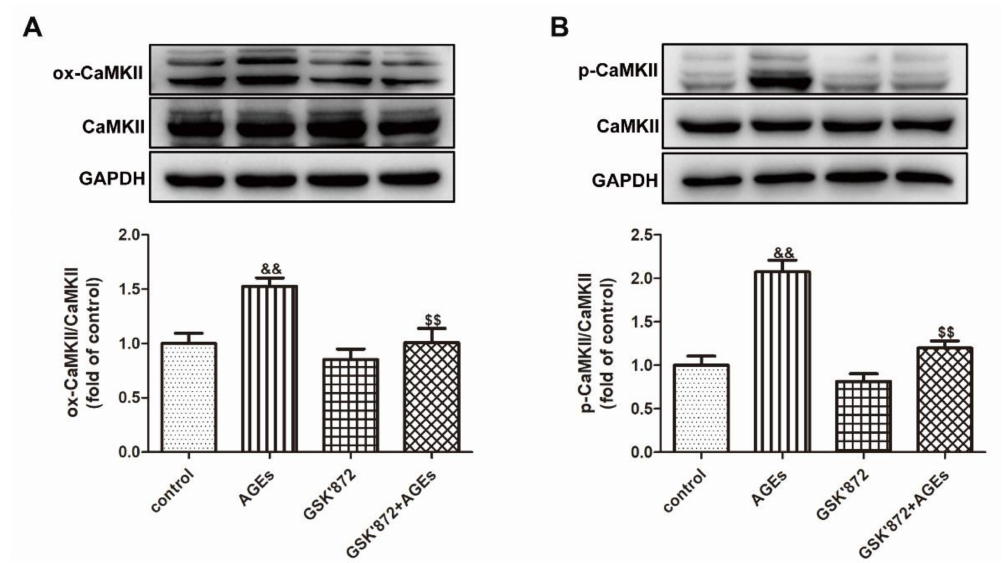
Figure 13. GSK (cid:48) 872 pretreatment inhibited CaMKII activation in cardiomyocytes. Cardiomyocytes were pretreated with 10 µ M GSK (cid:48) 872 for 4 h followed by 200 µ g/mL AGEs stimulation for 24 h. ( A ) The expression of ox-CaMKII and CaMKII was detected by Western blot in cardiomyocytes. GAPDH was used as a loading control. ( B ) The expression of p-CaMKII and CaMKII was detected by Western blot in cardiomyocytes. GAPDH was used as a loading control. Plots represent the mean ± SEM; n = 6. Statistical significance: && p < 0.01 compared with control; $$ p < 0.01 compared with AGEs. 2.14. GSK (cid:48) 872 Pretreatment Attenuated Oxidative Stress in Cardiomyocytes